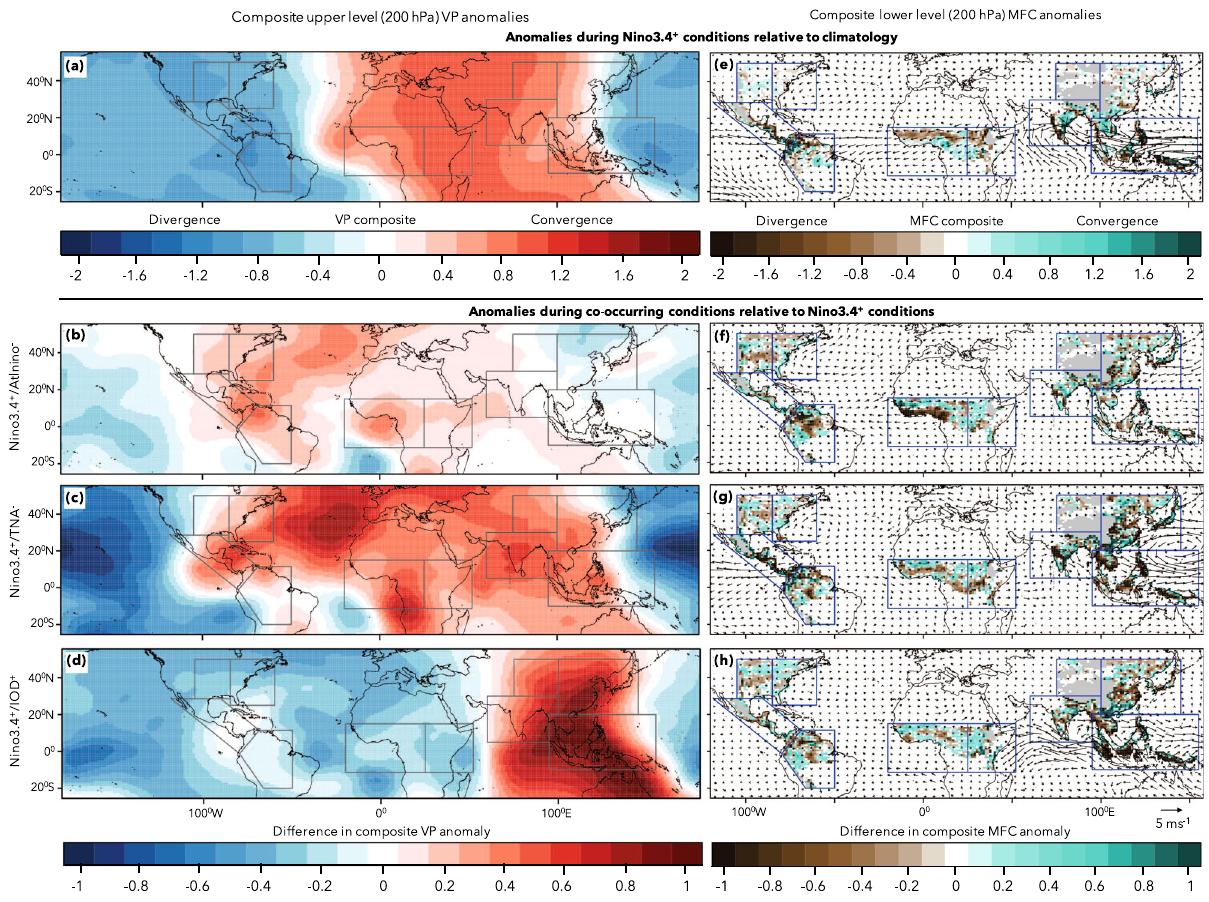
Fig. 7 Mechanism of compound droughts associated with co-occurring modes. Composite anomalies of a upper-level (200 hPa) velocity potential (VP) and e lower-level (850 hPa) moisture fl ux convergence (MFC) during Niño3.4 + conditions. Shading indicates the moisture fl ux convergence and arrows indicate winds. Differences of the VP and MFC composites associated with co-occurring b , f Niño3.4 + /Atl Niño − , c , g Niño3.4 + /TNA − , and d , h Niño3.4 + /IOD + conditions relative to Niño3.4 +